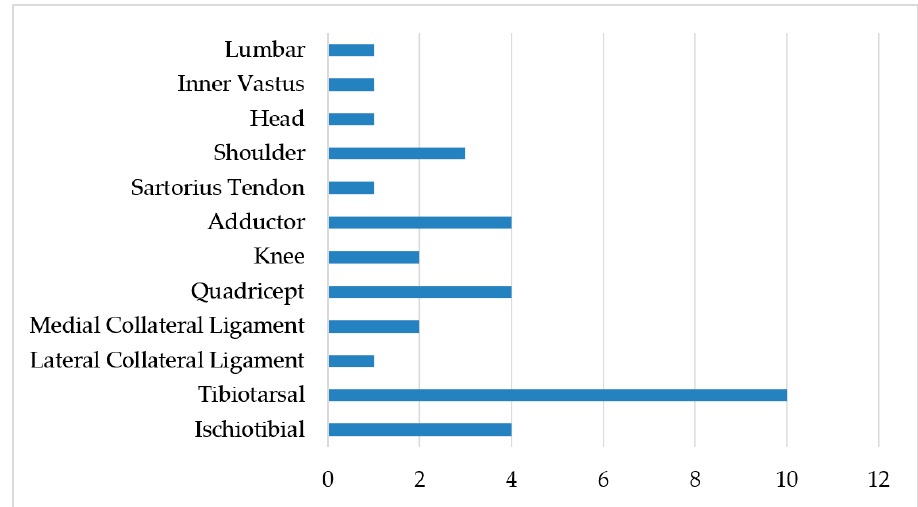
Figure 3. Injury frequency by specific location ( n ).